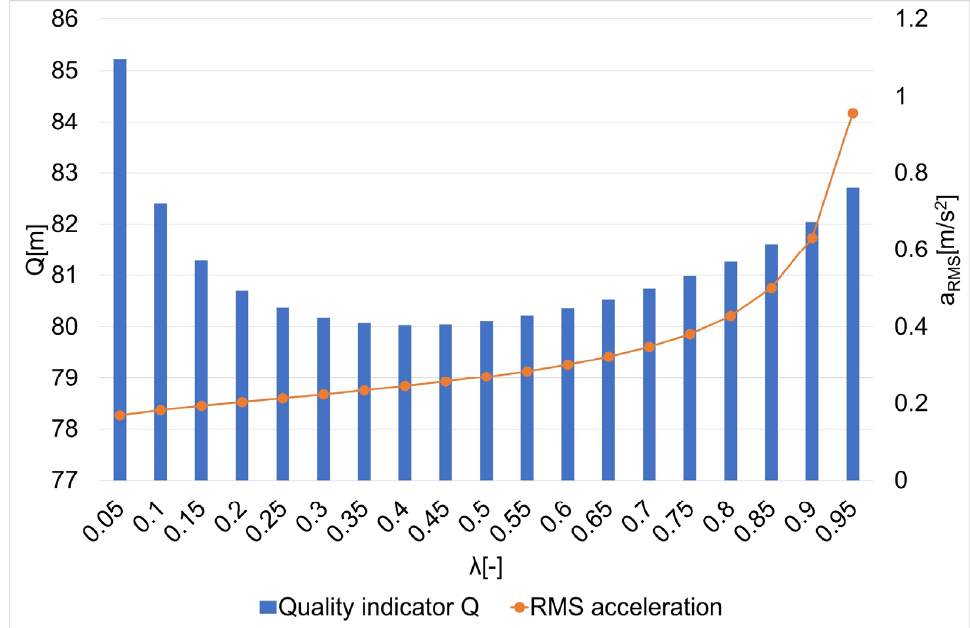
Figure 10. The values of the quality indicator Q and the mean square value of acceleration a RMS for the smoothing parameters in the case of path no. 6 [6].